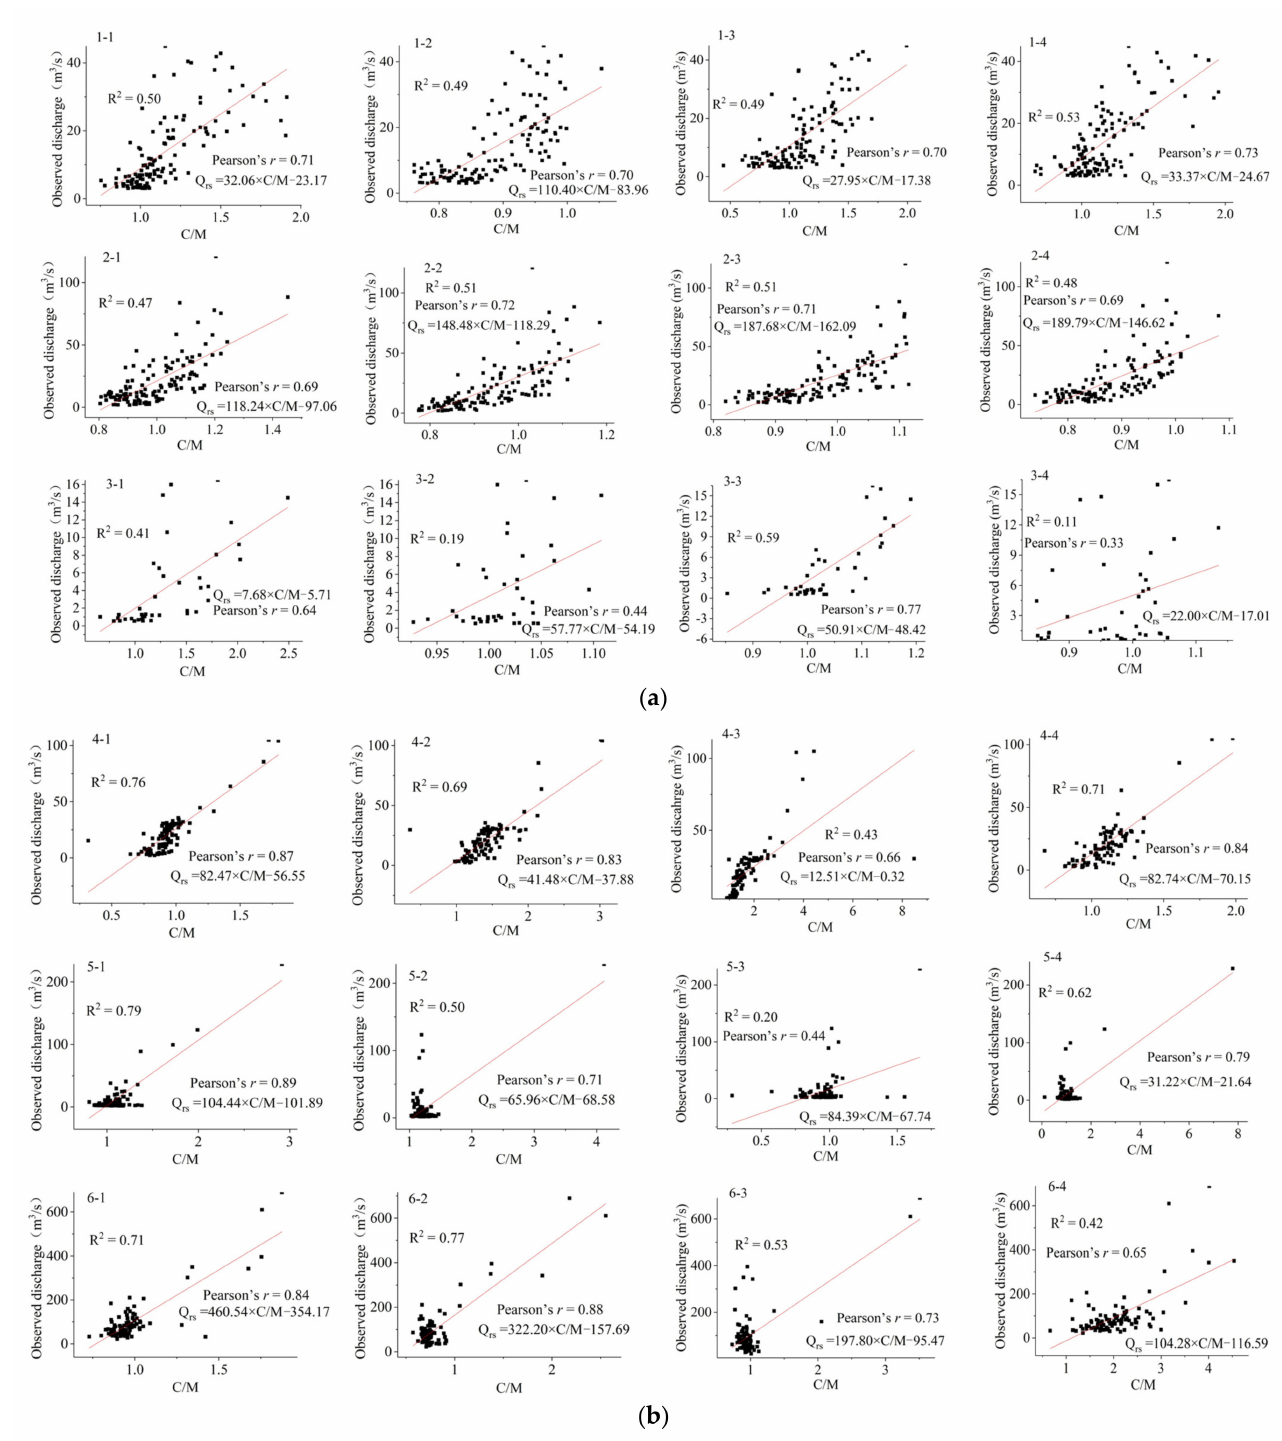
Figure 5. The scatter plots of C/M series and observed discharge. ( a ) Sites of the Heihe River Basin; ( b ) Sites of the Murray Darling